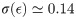
Distribution of epistasis vales, ω(ϵ), for (red) data points satisfying the condition defined in Fig 1.The width of the distribution is σ(ϵ)≃0.14.